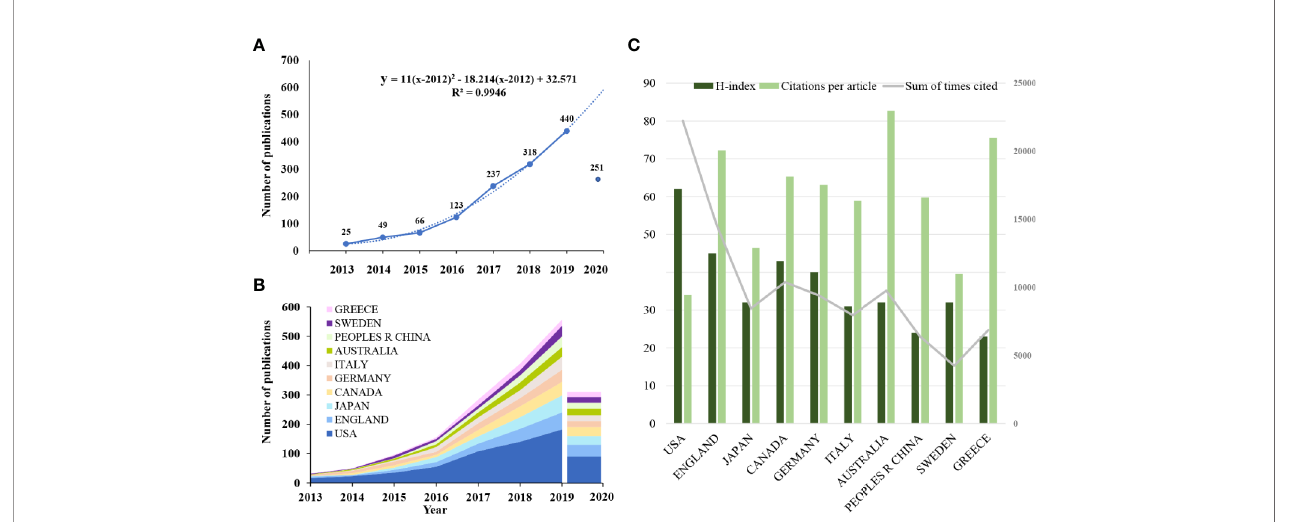
FIGURE 1 | Trends in the number of publications and analysis of country/regions in SGLT2 inhibitors in cardiovascular research. (A) The annual worldwide publication output. (B) Growth trends in the publication output from the top 10 countries. (C) H-index, citations per article, and total number of citations for the top 10